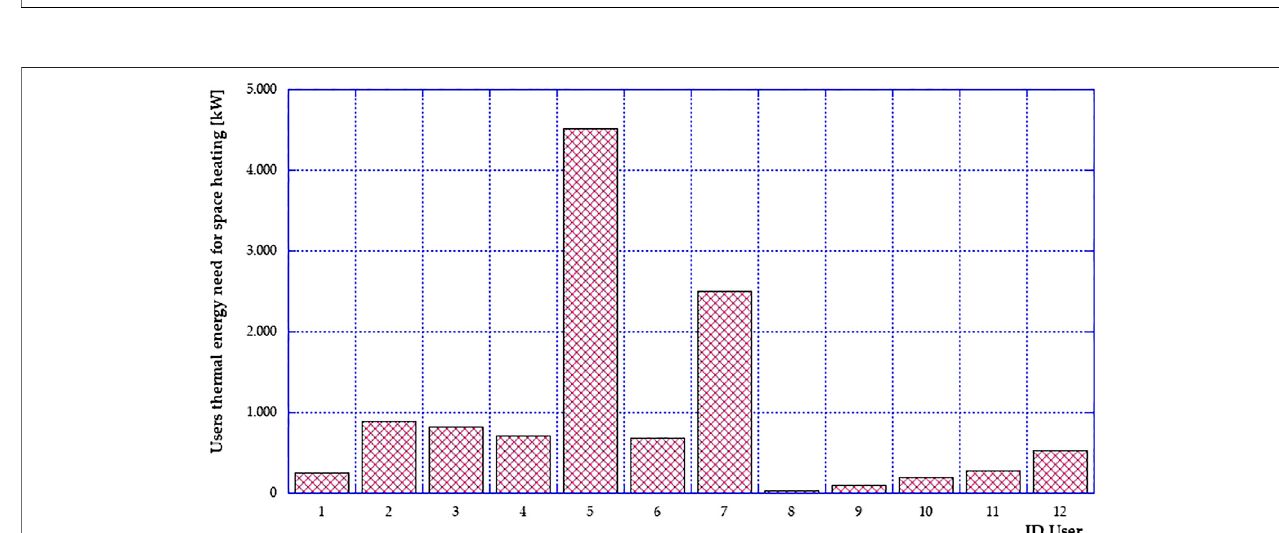
FIGURE 2 | Scheme of the DHN within the university campus.